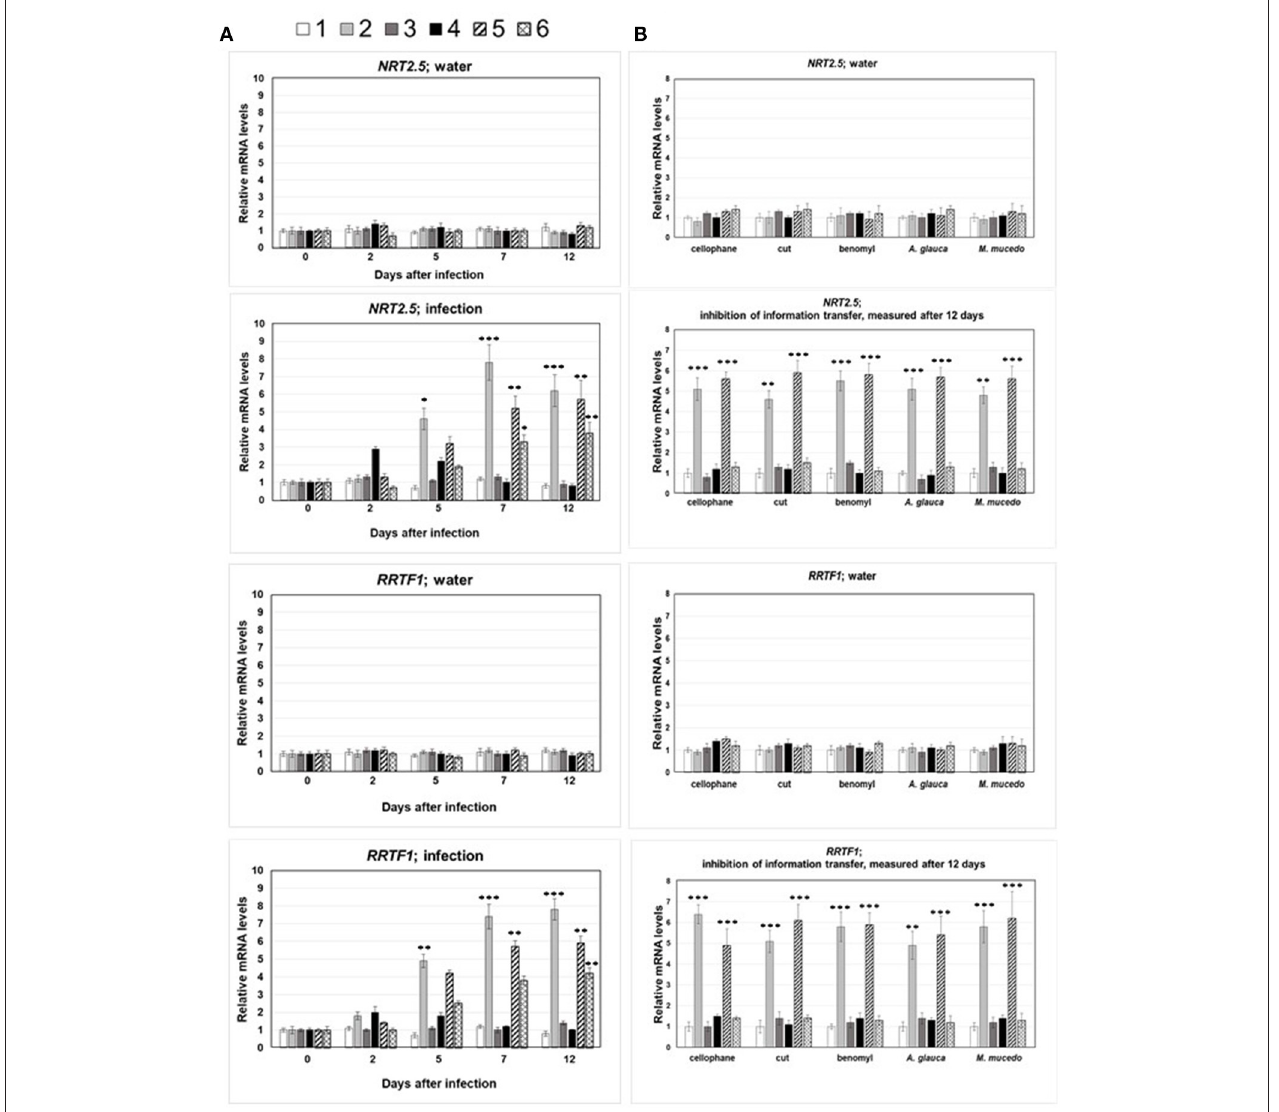
FIGURE 4 | (A) NRT2.5 and RRTF1 mRNA levels in infected and systemic leaves following A. brassicae spore application at day 0. The seedlings were either mock-treated (water) or inoculated with A. brassicae spores (infection). The numbers 1–6 refer to the seedlings shown in Figure 3A : 1, no treatment; 2, A.